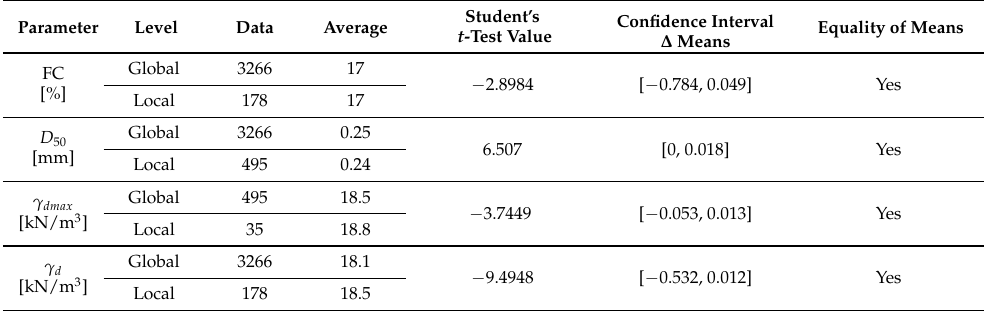
Table 5. Results from the test of equality of means at global and local scales. Confidence level: 99.9%. Parameter